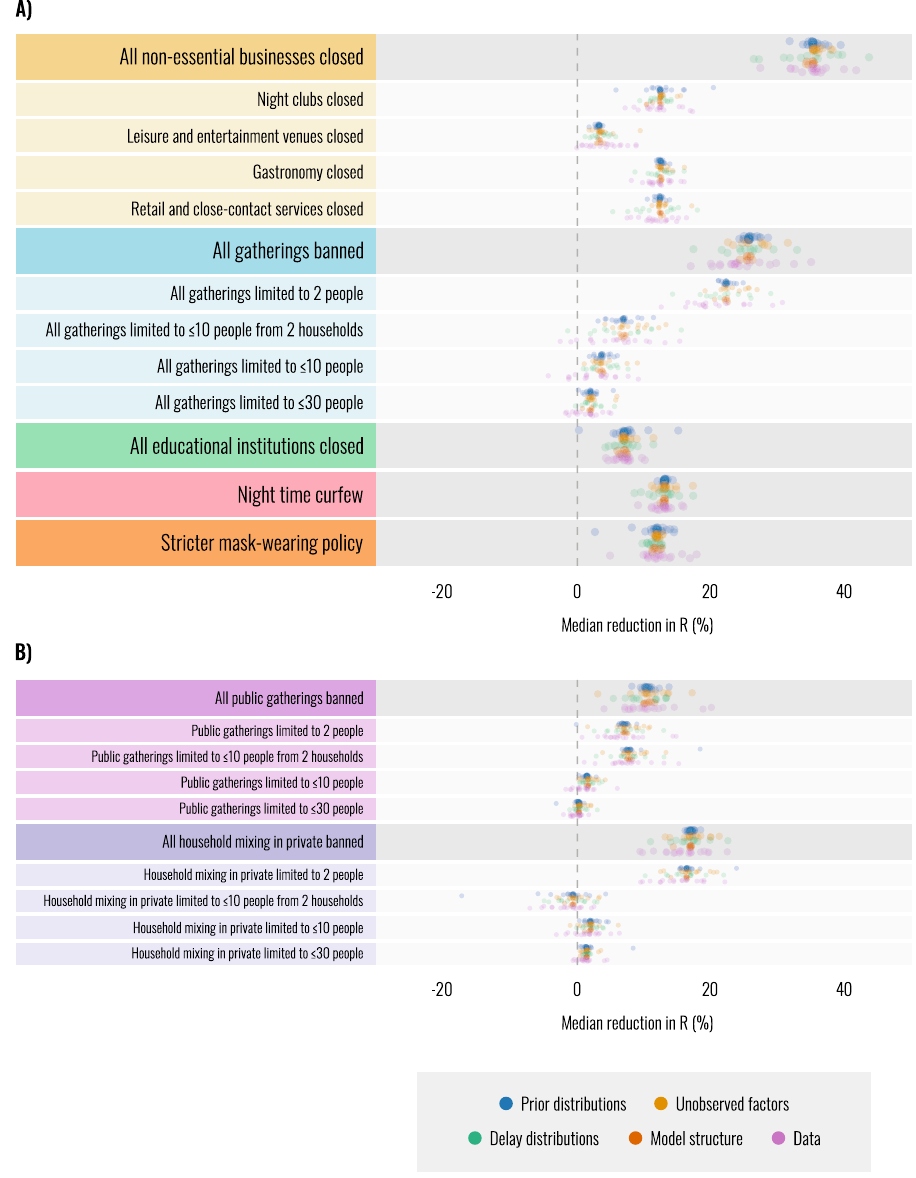
Fig. 3 Robustness of median intervention effectiveness estimates across n = 86 experimental conditions (univariate sensitivity analysis). Each dot represents the posterior median intervention effectiveness under a particular experimental condition. This fi gure contains only univariate sensitivity analysis — please see Supplementary Note 2.2 for multivariate sensitivity. Dot colour indicates categories of sensitivity analyses. Each category contains several sensitivity analyses (17 in total) and each sensitivity analysis contains several experimental conditions ( n = 86 in total). Supplementary Table S1 lists all sensitivity analyses by category. A Robustness of effectiveness estimates of the main interventions included in our study. Intervention names preceded by “ All ” show the combined effect of multiple interventions. For example, “ All gatherings banned ” shows the combined effect of banning all public gatherings and all households mixing in private. B Robustness of the individual effectiveness estimates for separately banning public gatherings or household mixing in